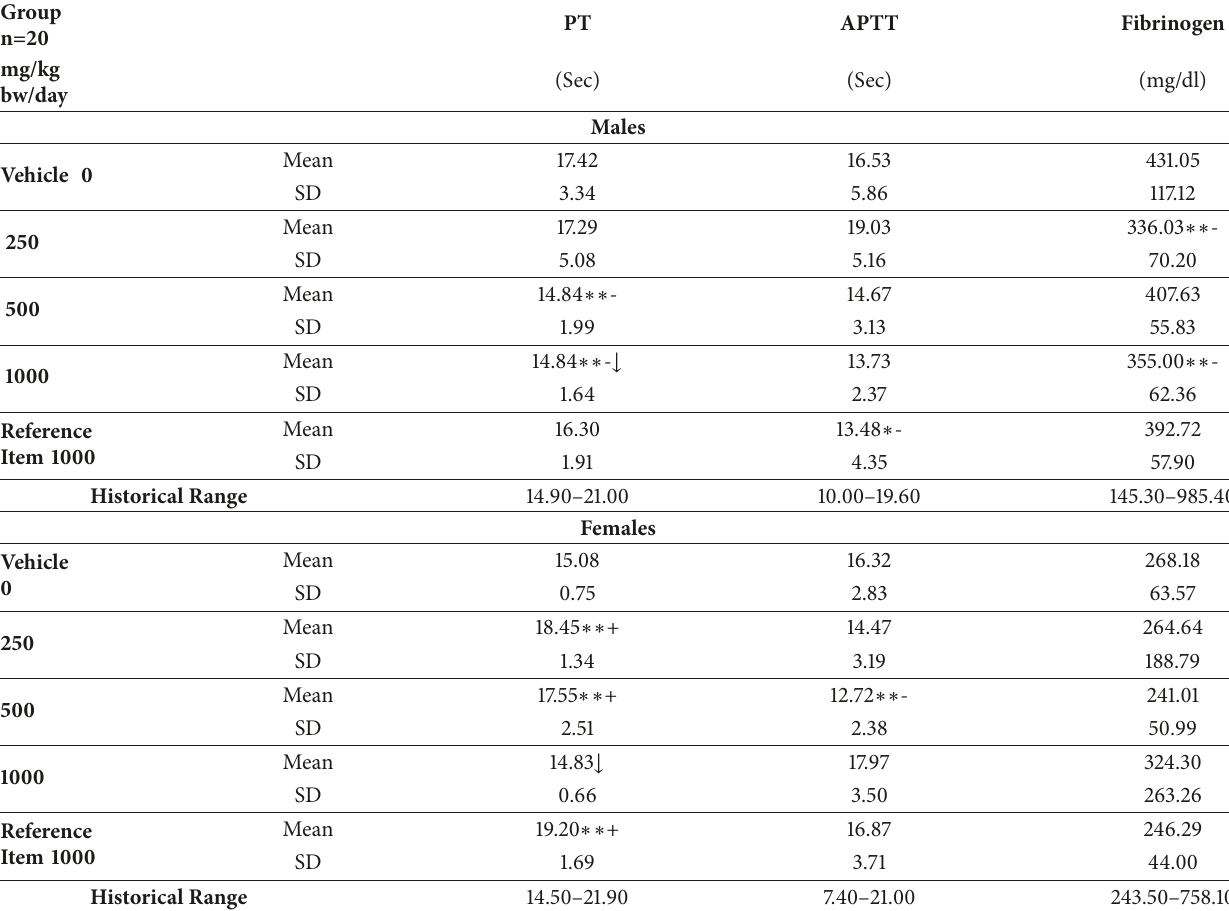
Table 11: Summary of coagulation parameters for the 90-day study on